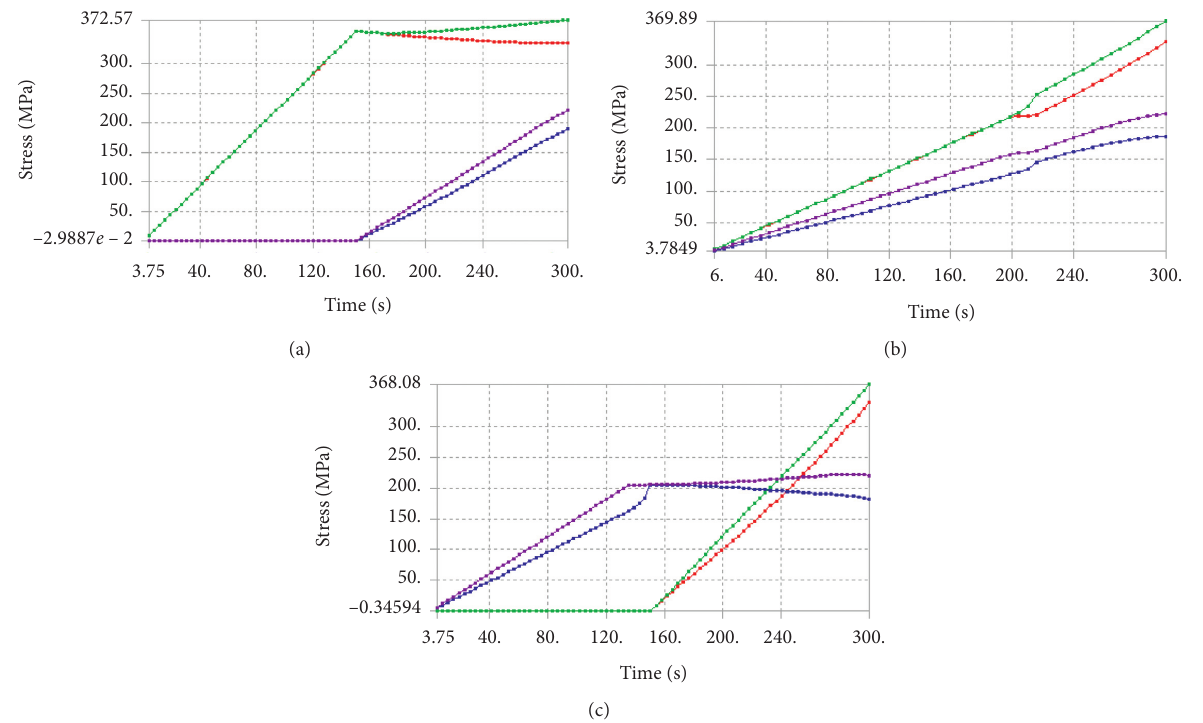
Figure 13: σ z and τ θ z of stress paths A (a), B (b), and C (c). Note. The green and red lines represent the maximum and minimum values of normal stress, respectively. The purple and blue lines represent the maximum and minimum values of shear stress, respectively.